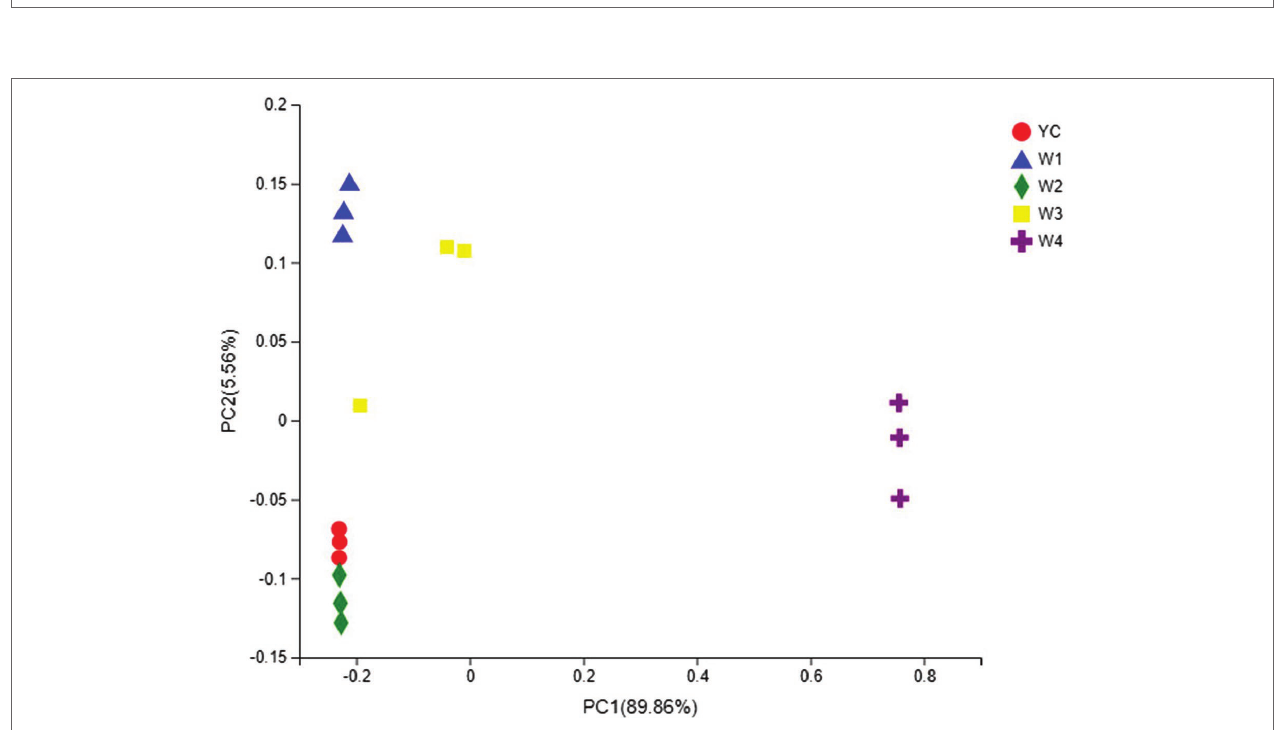
FIGURE 6 | Multiple sample principal coordinate analysis (PCoA) of OTUs. Both selected principal component axes are represented by the x - and y -axes, and the percentage represents the difference in sample composition as determined by the principal component; the scales of the x - and y -axes are the relative distances. Samples are shown as different color points or shapes in different groups. The closeness of two points or shapes represents the similarity between the species composition of two